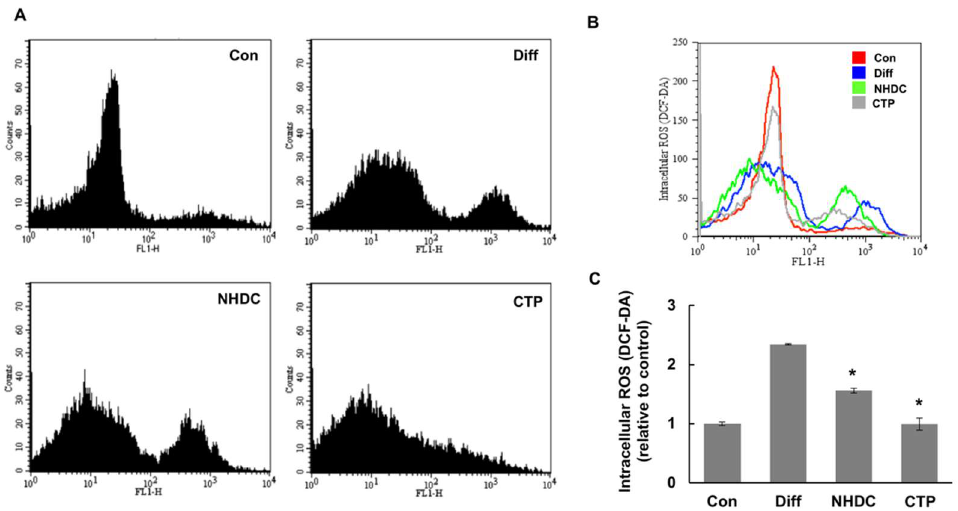
Figure 6. ROS-mediated adipogenic differentiation in hASCs. hASCs were treated with normal growth medium for 5 days and then treated with adipogenic differentiation medium with NHDC or its analogue for 14 days. Meanwhile, the control group was treated with growth medium for 5 days. Intracellular ROS levels were estimated by flow cytometric analysis of DCF fluorescence after staining cells with DCFH-DA. Flow cytometric distribution of DCFDA stained hASCs. ( A ). Flow cytometric distribution among all experimental groups was merged to see the cellular ROS level ( B ). Cell granularity of DCF-fluorescence was evaluated ( C ). The results are expressed as the mean values ± SD ( n = 3); * p < 0.01 as compared to the differentiation group (Diff). Con, control group cultured in growth medium only; Diff, differentiation group cultured in adipogenic differentiation medium.